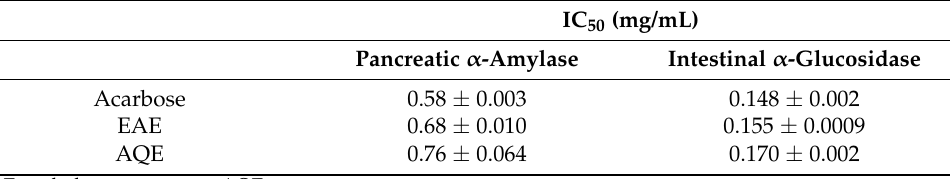
Table 3. The IC 50 values of A. absinthium extracts and acarbose in pancreatic α -amylase and intestinal α -glucosidase